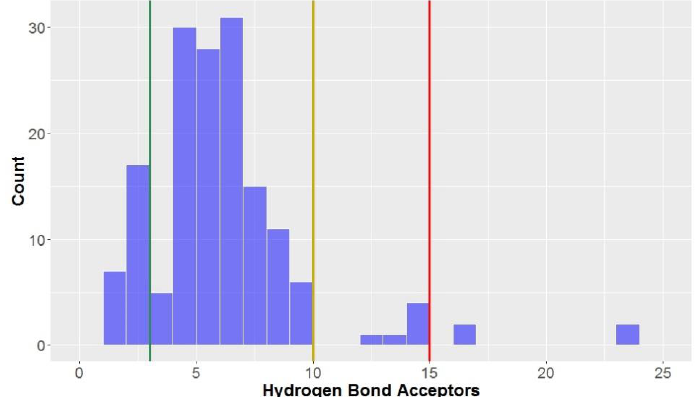
Figure 6. The statistical distribution of the hydrogen bond acceptors of all analysed compounds (green = 3, compounds < 3 are in the lead-like space; yellow = 5, compounds < 5 are in the drug-like space; red = 15, compounds < 15 are in the KDS). Total number of compounds = 160.